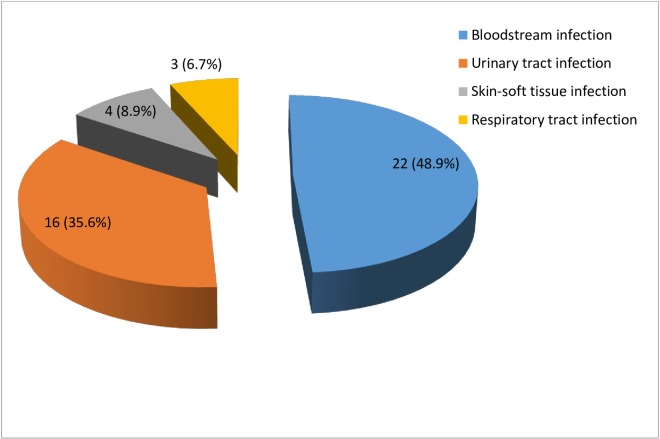
Distribution of Intensive Care Unit-acquired infections in Lagos University Teaching Hospital, Lagos.Bloodstream infection (48.9%); Urinary tract infection (35.6%); Skin-soft tissue infection (8.9%); Respiratory tract infection (6.7%).